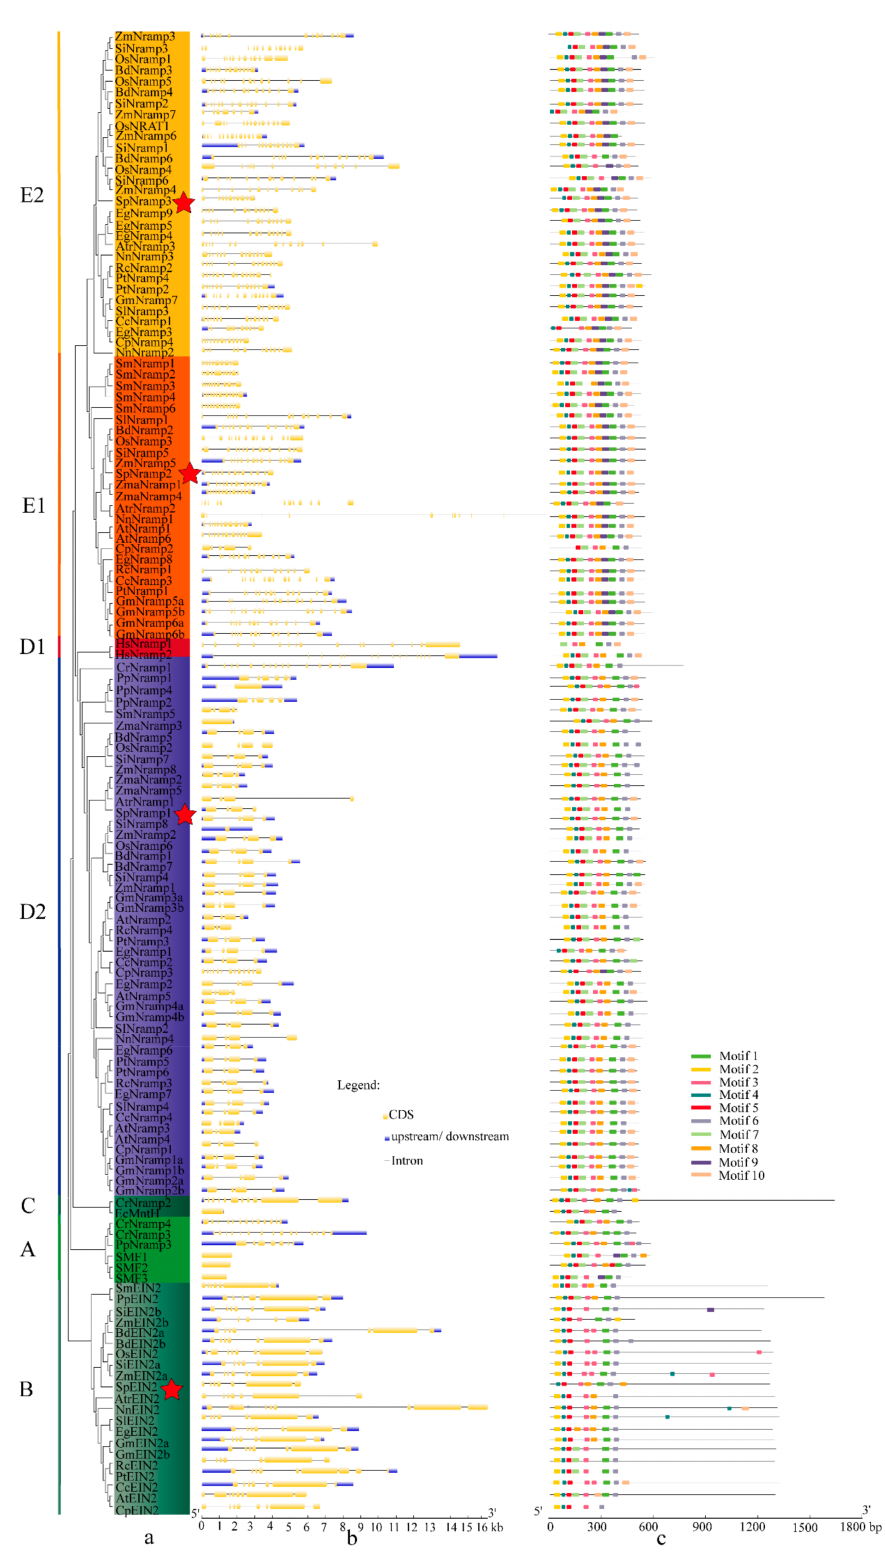
Figure 2. Phylogenetic relationship, gene structure, and conserved motif of Nramp genes. ( a ). Phylogenetic tree of 138 Nramp proteins. ( b ). Intron–exon structures of Nramp genes. Blue boxes represent the upstream/downstream region, and yellow boxes represent exons and black lines represent introns of Nramp proteins. ( c ). Number and distribution of conserved motifs in Nramp genes. Ten putative motifs were predicted by MEME, and various colors represent different colored boxes. Details of motifs are summarized in Table